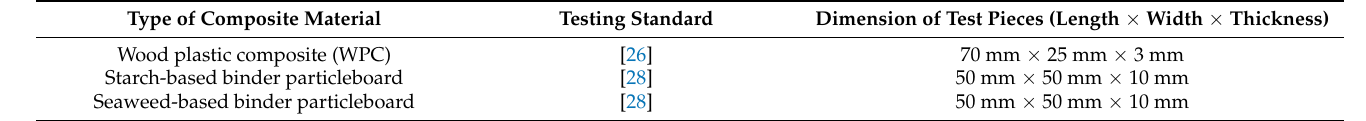
Table 5. Thickness swelling and water absorption tests standards for different type of composite